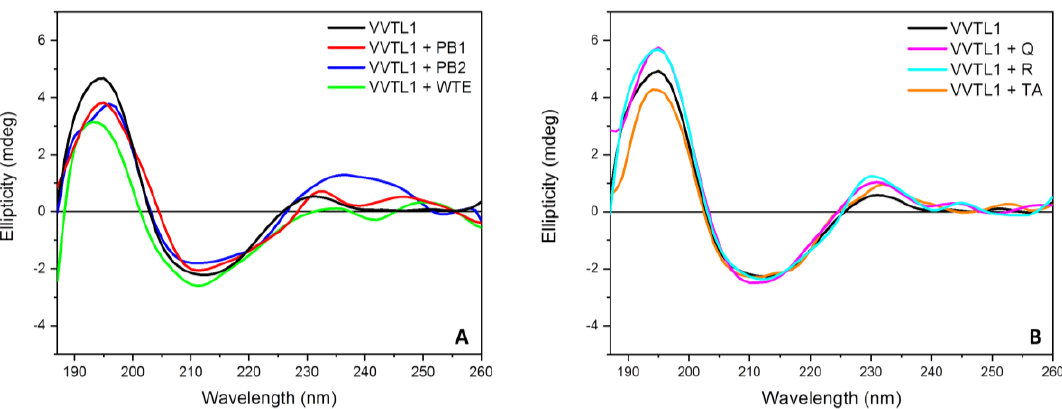
Figure 3. Far-UV Synchrotron Radiation Circular Dichroism (SRCD) spectra of VVTL1 (0.400 mg/mL) alone (black line in both pictures) or in presence of 2 eq. of polyphenols ( A : PB1 in red, PB2 in blue, wine total extract (WTE) in green; B : Q in magenta, R in cyan, TA in orange) in model wine solution (MWS). Spectra were recorded at 20 °C using a Suprasil 0.02 cm cell (Hellma) filled with 60 µL of solution, integration time 1 s, 1 nm digital resolution, 39 nm/min. scan speed, and monochromator slit widths 1.2 nm bandwidth.